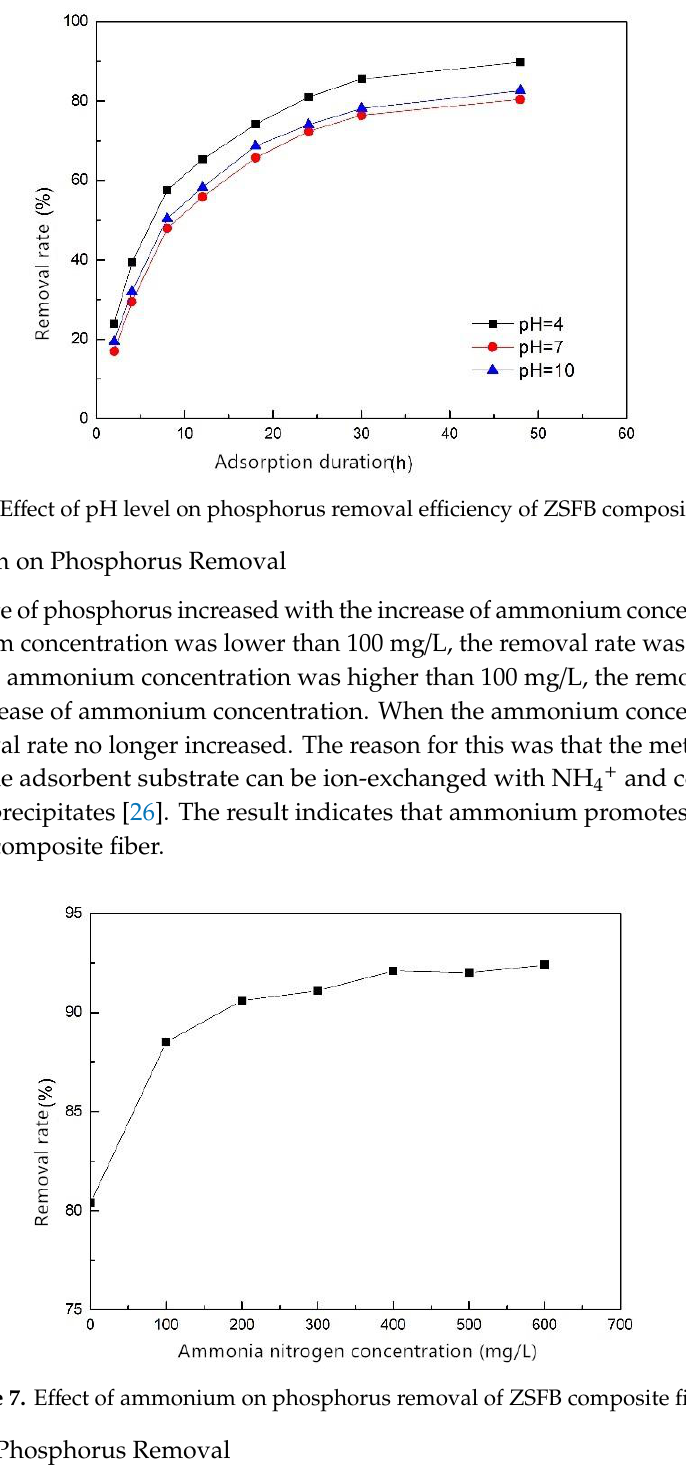
Figure 8. Effect of anion on phosphorus removal efficiency of ZSFB composite fiber. 3.1.4. Adsorption Stability